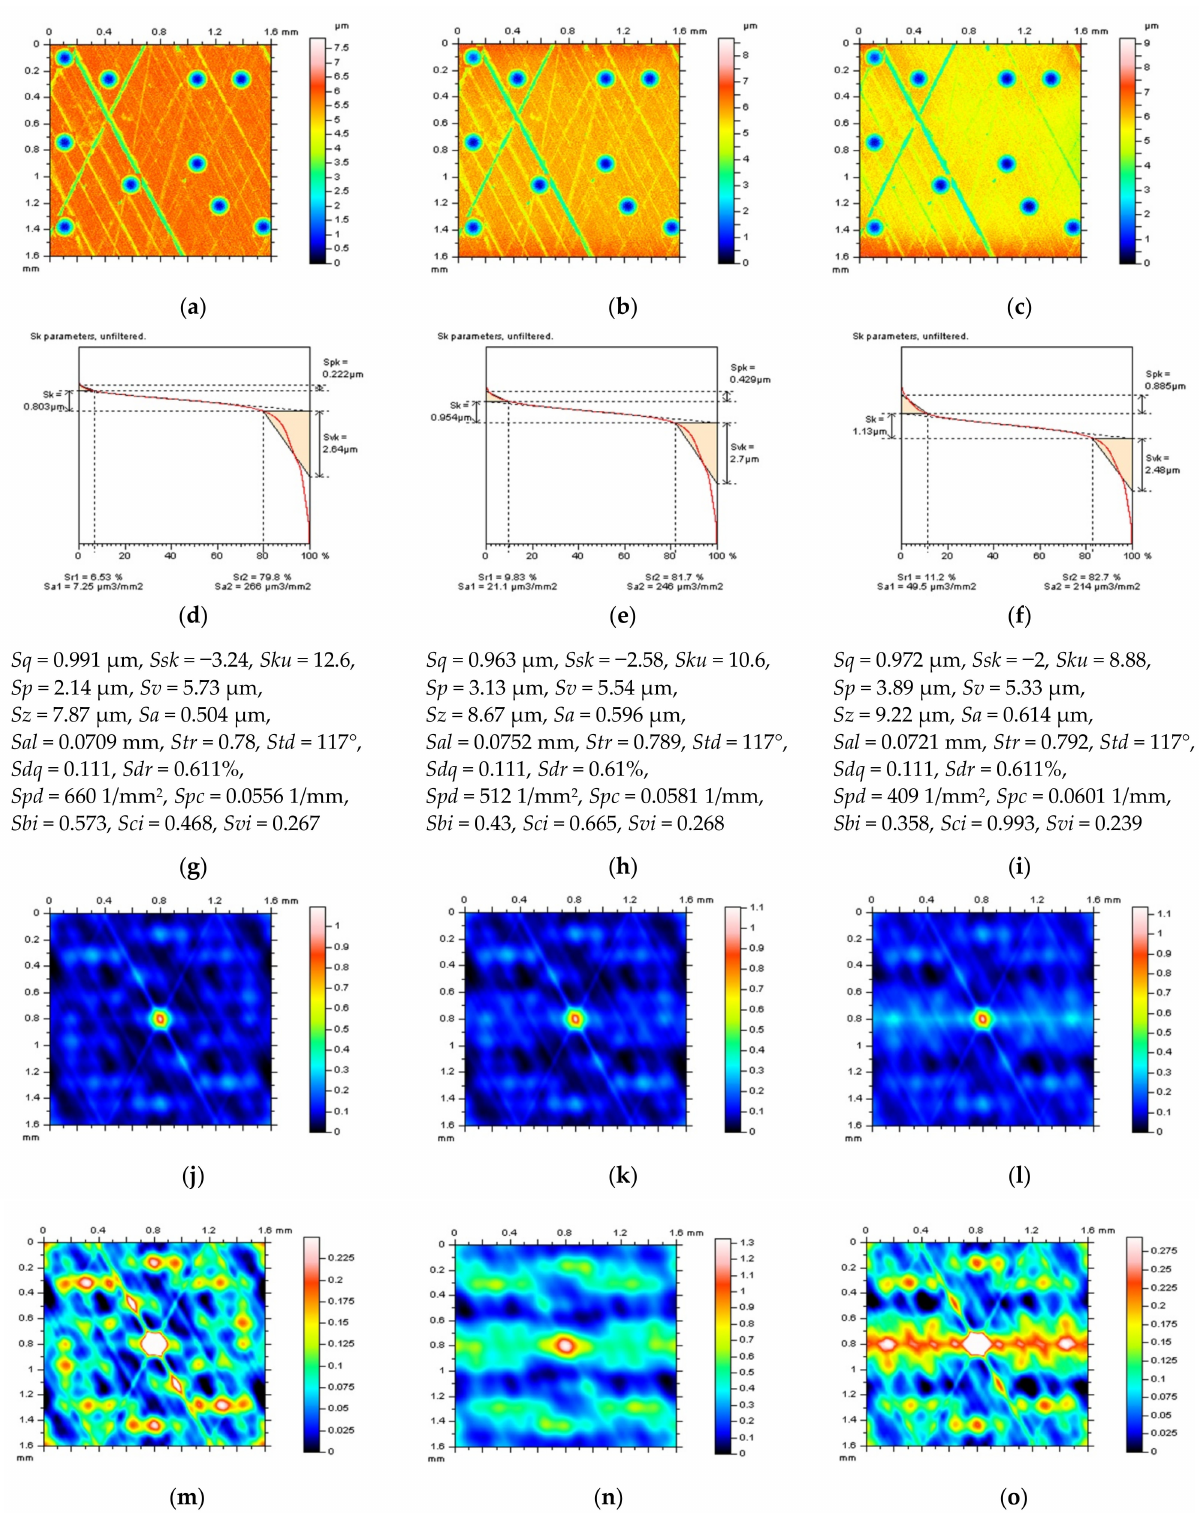
Figure 6. L-surfaces ( a – c ), their material ratio curves ( d – f ), and ISO 25178 parameters ( g – i ), the 3D ACF of L-surfaces ( j – l ) and their thresholded (1–99%) parts ( m – o ), received after the areal form removal by application of POLY2 (left column), RGRF (middle column), and SF (right column), cutoff = 0.8